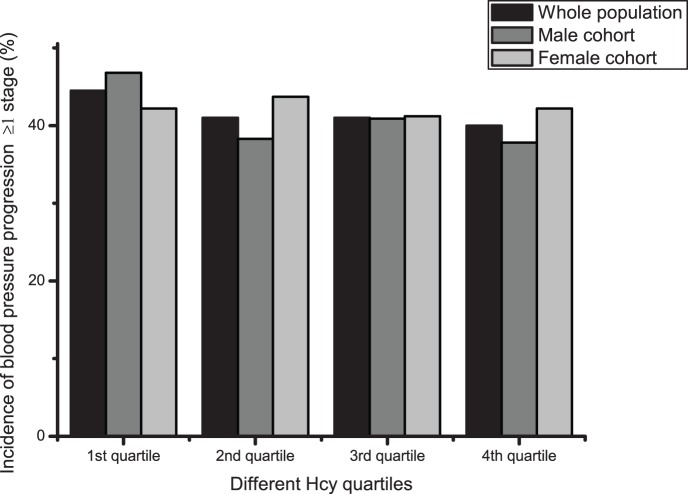
Blood pressure progression incidences within different Hcy quartiles.Black bar: Whole population; Dark gray bar: Male cohort; Light grey bar: Female cohort.